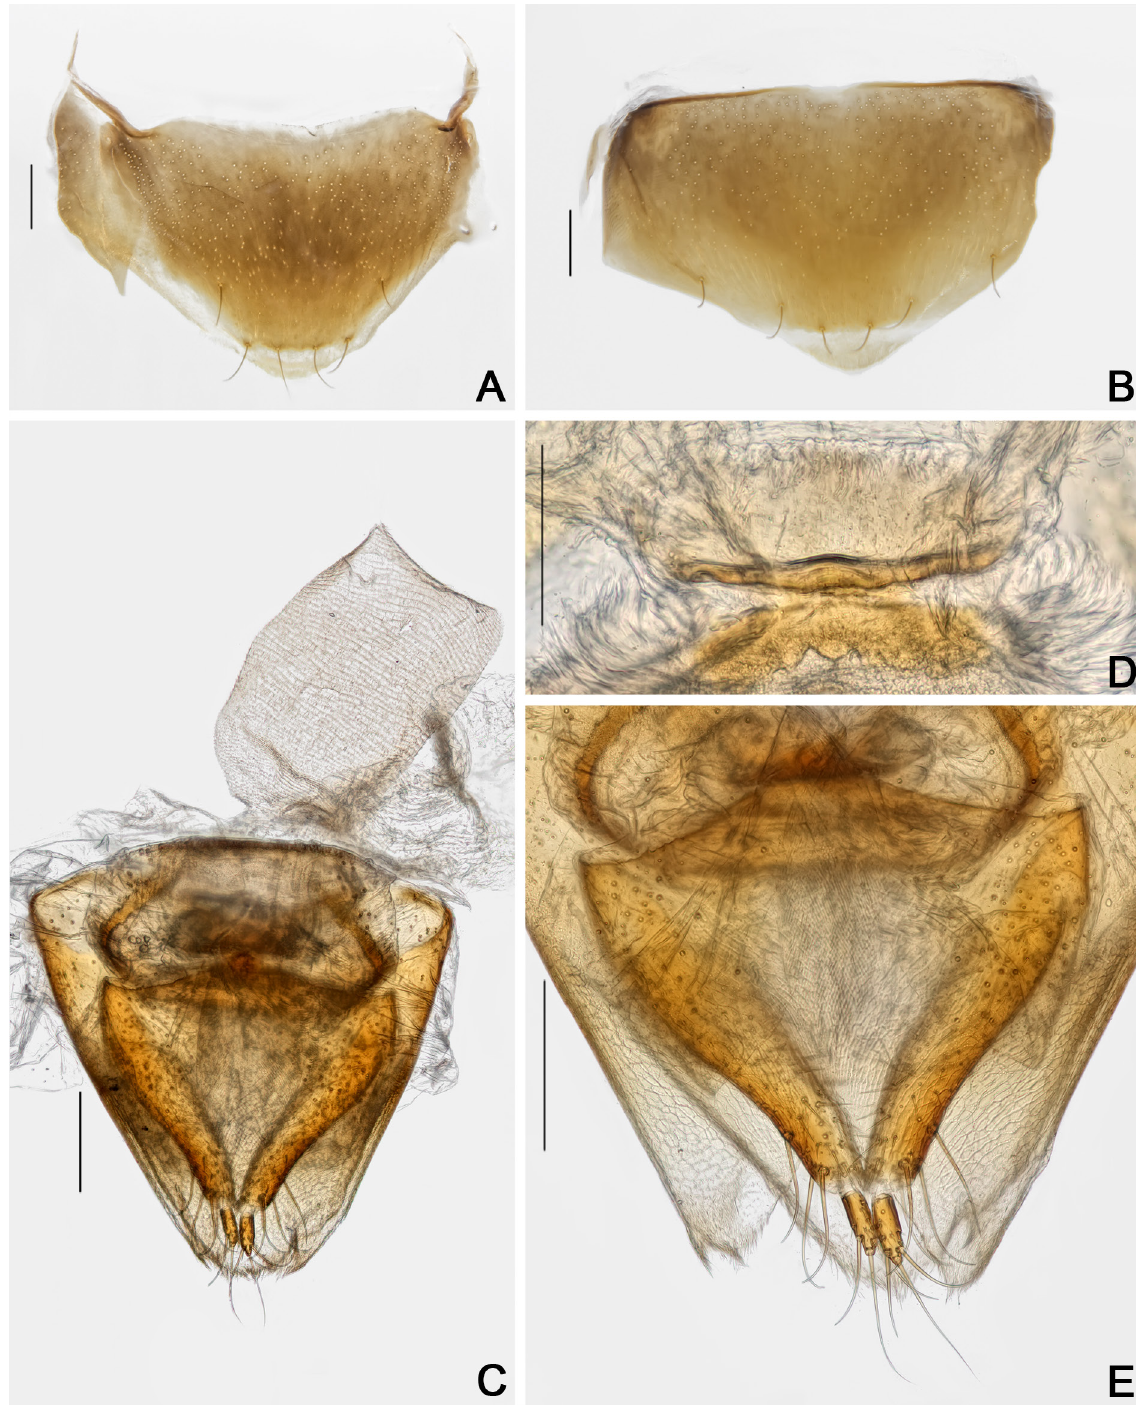
Fig. 63. Cyparium oberthueri Pic, 1956, ♀ (CELC). A . Tergite VIII. B . Sternite VIII. C . Terminalia. D . Sclerite of vaginal plate. E . Ovipositor. Specimen collected at Mata da Biologia, Viçosa (MG, Brazil). Scale bars: A–C, E = 0.2 mm; D = 0.1